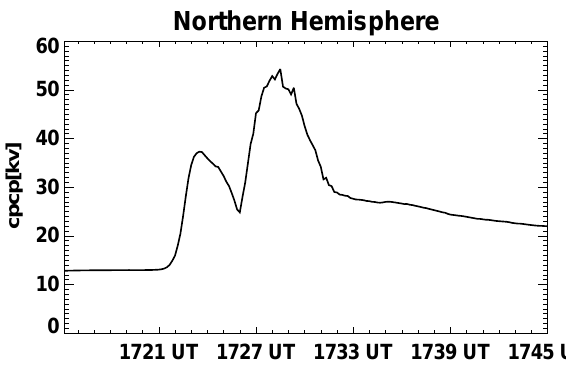
Fig. 1. Cross polar cap potential as a function of time when the high pressure solar wind hits the bow shock around 17:20UT with northward IMF